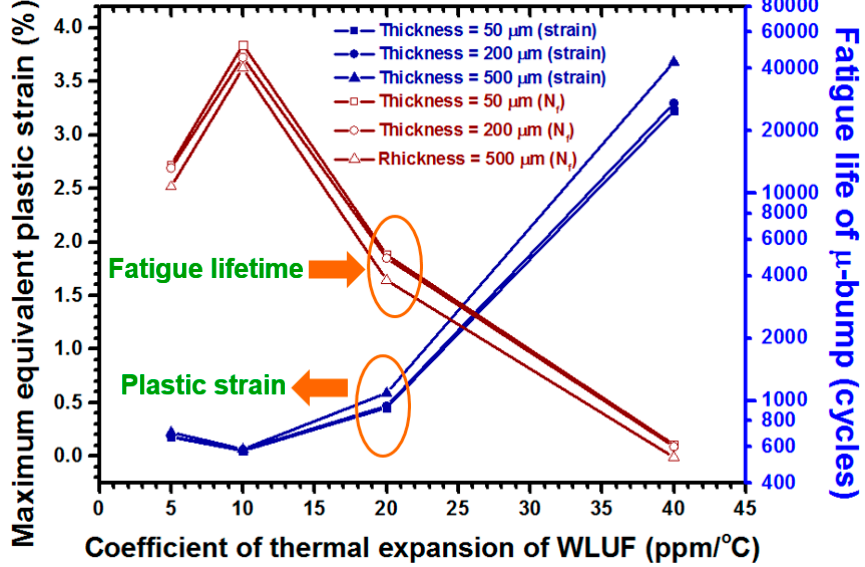
Figure 12. Maximum equivalent plastic strain and fatigue lifetime estimation for the outermost μ -bump in the first layer of stacked chips, in the present 3D-IC package, given several CTEs of